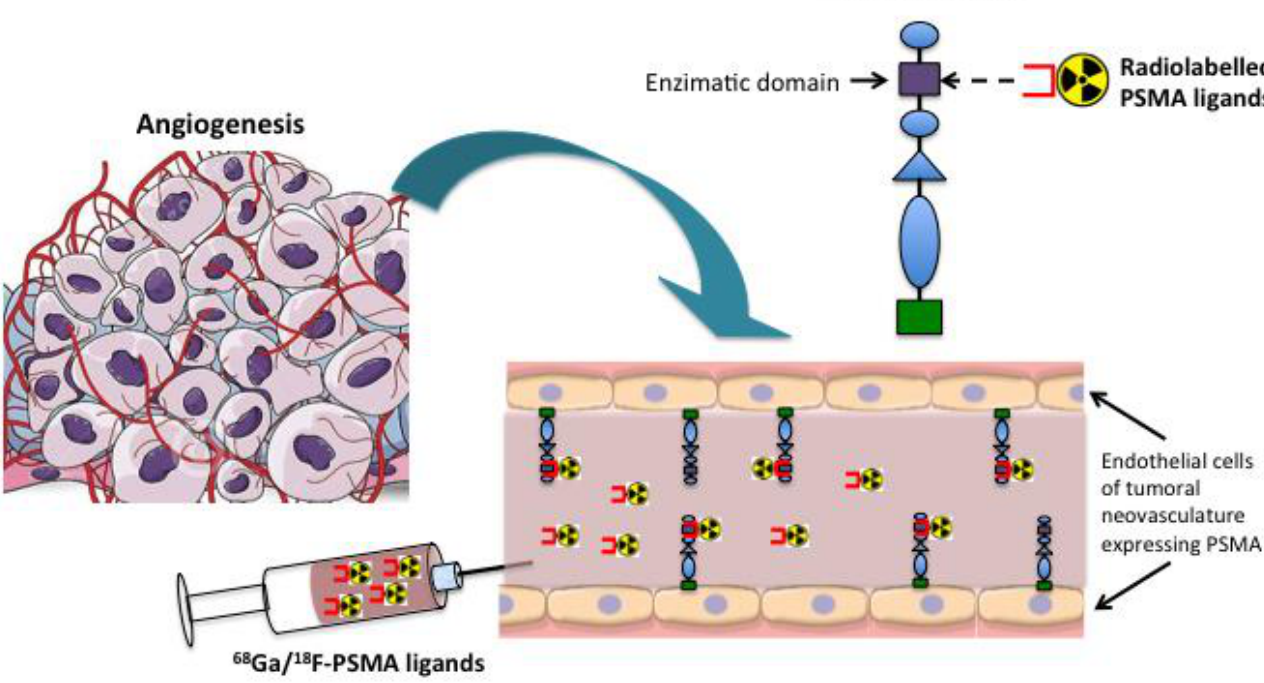
Figure 1. Mechanism of expression of PSMA in the neovasculature of non-prostatic tumors.